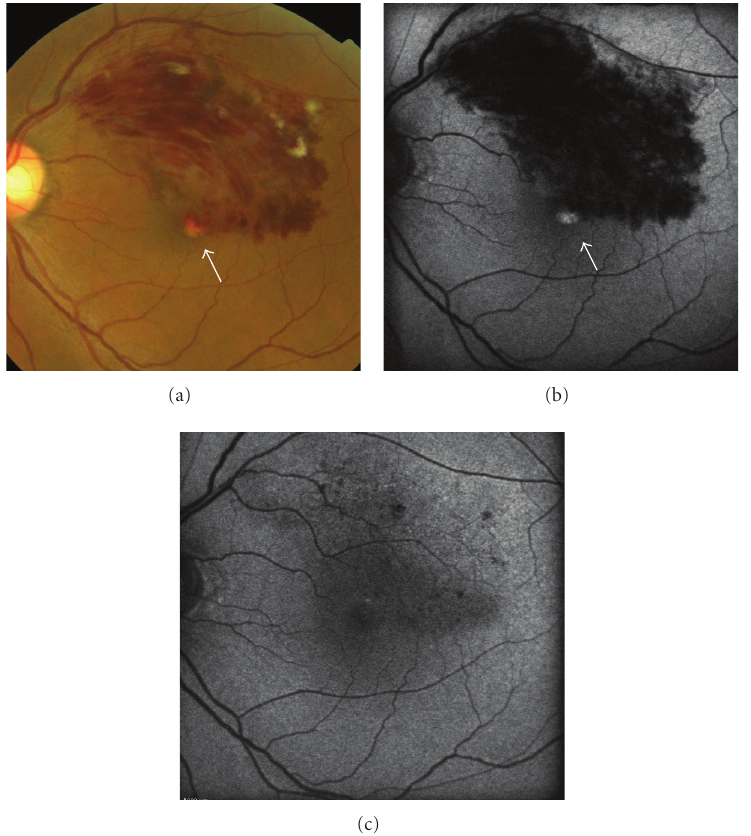
Figure 2: Fundus photograph and fundus autofluorescence images for Patient 5 (a 60-year-old man). Color fundus photograph (a) and fundus autofluorescence (b). Yellowish deposition (white arrow) appeared at the fovea 2 months after the onset of BRVO. Hyperautofluorescence disappeared after resolution of the deposits (c).